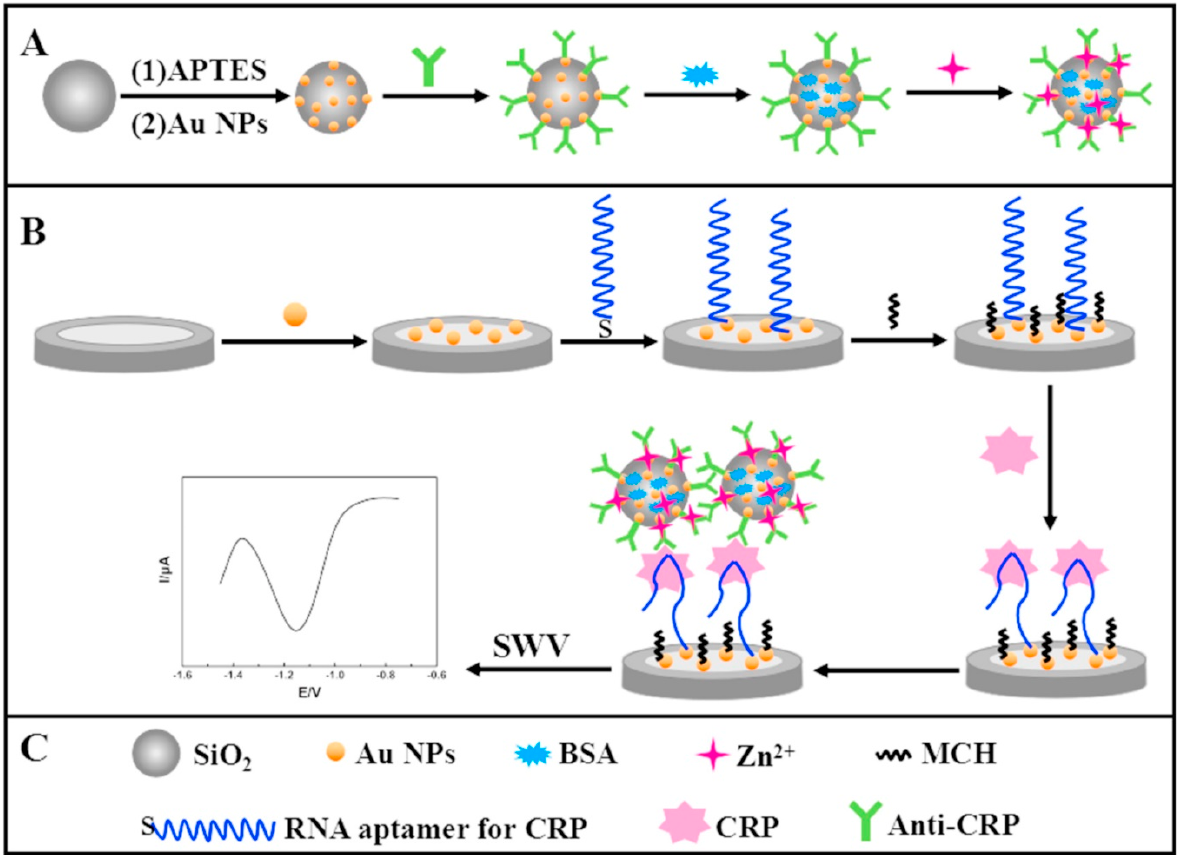
Figure 8. Schematic representation of fabrication process of the CRP aptasensor. ( A ) Preparation of immunoprobe Zn 2+ /Ab/Au NPs@Si MSs, ( B ) Fabrication of MCH/RNA/Au NP-modified electrode. ( C ) Depiction of the components of the CRP aptasensor. Reprinted with permission from reference [82]. Copyright Elsevier 2017.